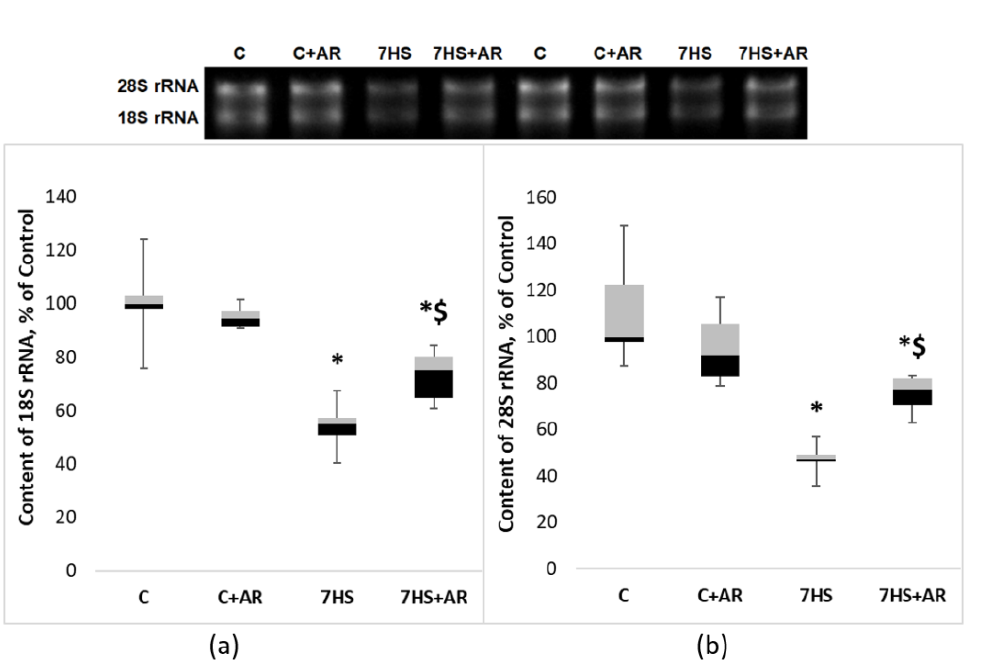
Figure 4. Effect of GSK-3 inhibition during 7-day unloading on the amount of 18S rRNA ( a ) and 28S rRNA ( b ) in rat soleus muscle. Data are presented as median, interquartile range, minimum and maximum values, expressed as % of control. C, vivarium control group, C + AR, vivarium control rats + daily injections of GSK-3 inhibitor (AR-A014418) for 7 days, 7HS, hindlimb suspension for 7 days, 7HS + AR, 7-day hindlimb suspension + daily injections of GSK-3 inhibitor (AR-A014418), *: p < 0.05 vs. C, $: p < 0.05 vs. 7HS.